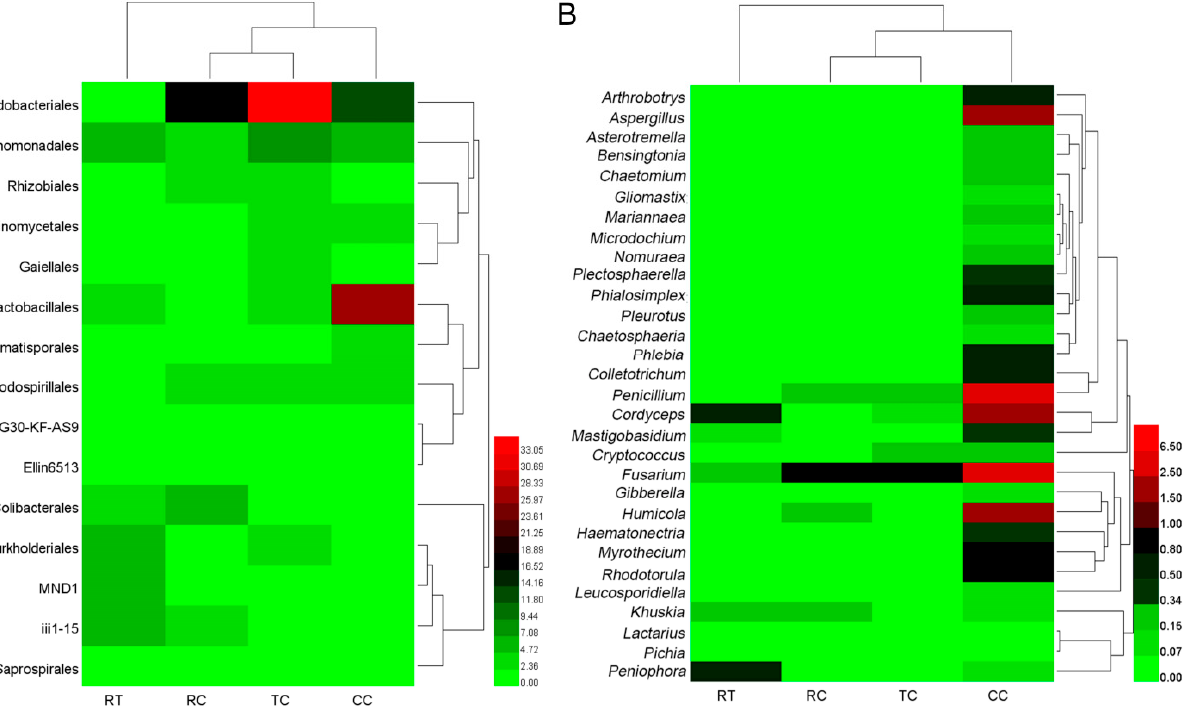
Figure 1. Composition of the main microorganism under four cropping patterns (( A ): 15 bacterial orders; ( B ): 30 fungal orders; ( B ): 30 fungal genera).